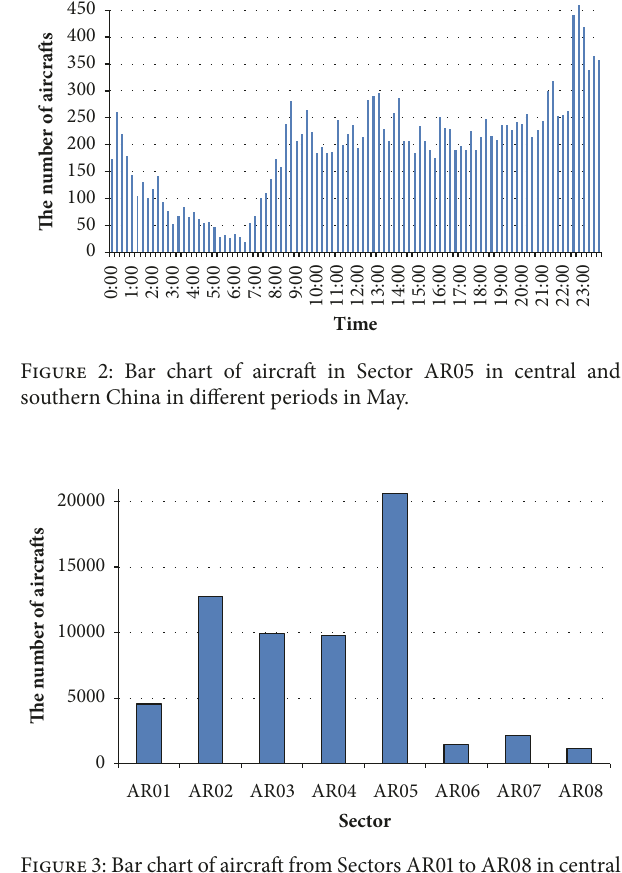
Figure 3: Bar chart of aircraft from Sectors AR01 to AR08 in central and southern China in